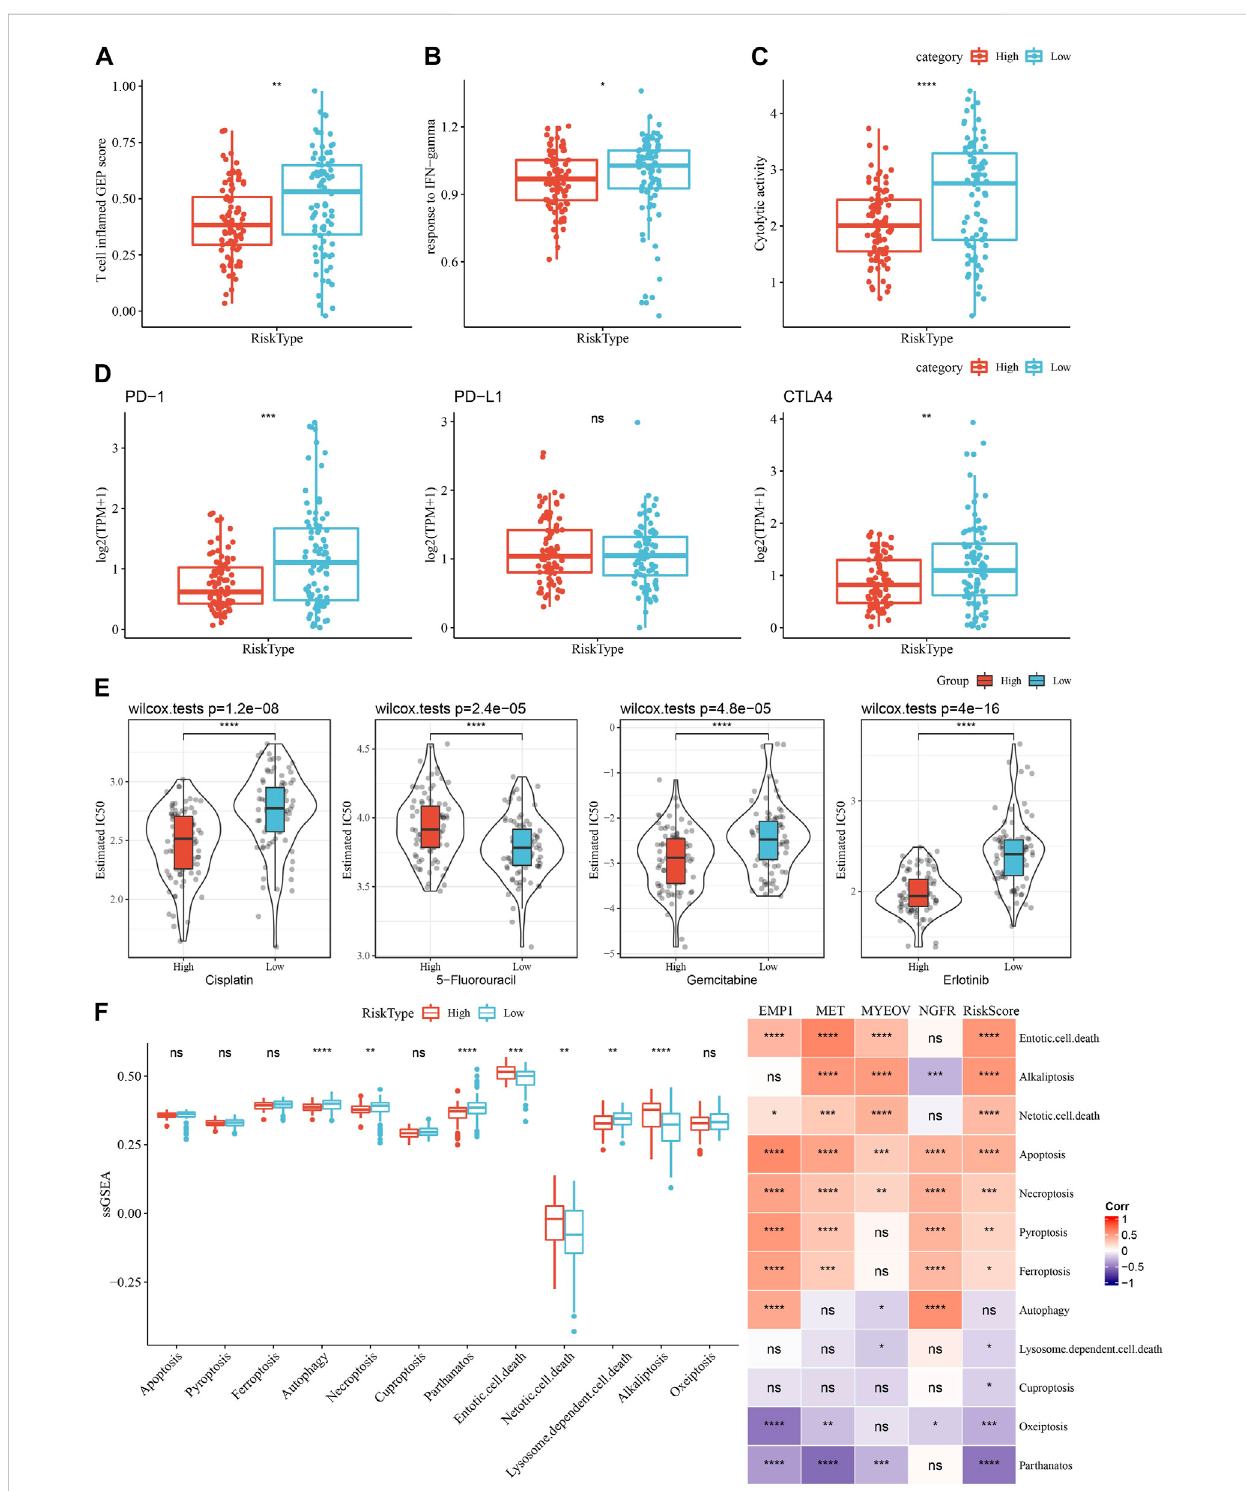
FIGURE 11 Comparison oftheimmunotherapyresponseandchemotherapysensitivitybetweentworiskgroupsinTCGA-PAADcohort. (A – C) Representedthe comparison of the T cell in fl amed GEP score, response to IFN- γ score and cytolytic activity between the two risk groups, respectively. (D) Differences of expressionICGsbetweendifferentgroups; (E) TheboxplotsoftheestimatedIC 50 forcisplatin,5-Fluorouracil,gemcitabineanderlotinibbetweentherisk groups. (F) Left, the ssGSEA score differences of 12 programmed cell death patterns between high- and low-group. Right, the correlation analysis between 12 programmed cell death patterns and